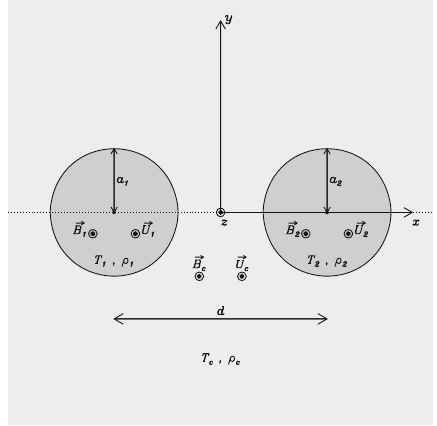
Fig. 49 Cross-section of a two-thread model analogous to that of Fig. 46 with the addition of mass flows along the cylinders. Image reproduced with permission from Soler et al. (2009c), copyright by